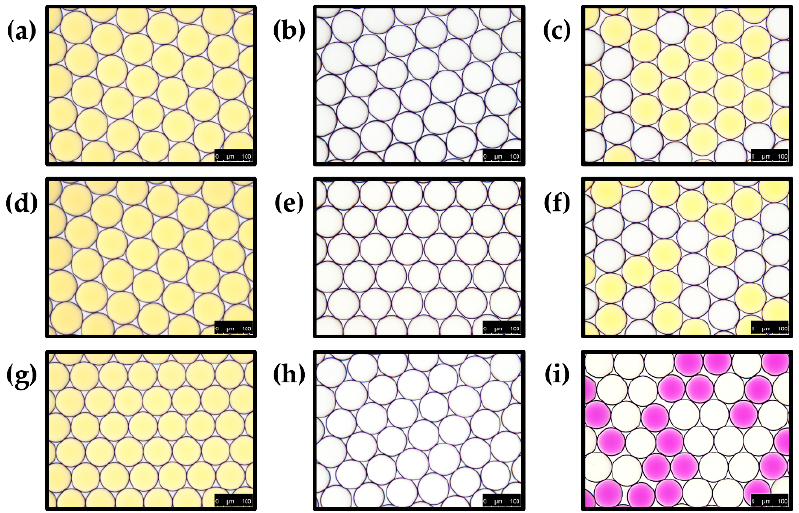
Figure 12. Identification of ammonia gas production within droplets and gas crosstalk between droplets. Phenol red droplets ( a , d , g ) were mixed sodium hydroxide-containing droplets ( b ), ammonium chloride-containing droplets ( e ) or co-encapsulated droplets with sodium hydroxide and ammonium chloride ( h ). Droplet mixtures ( c , f , i ) were then imaged under a DMi-8 microscope (scale bar = 100 μ m).